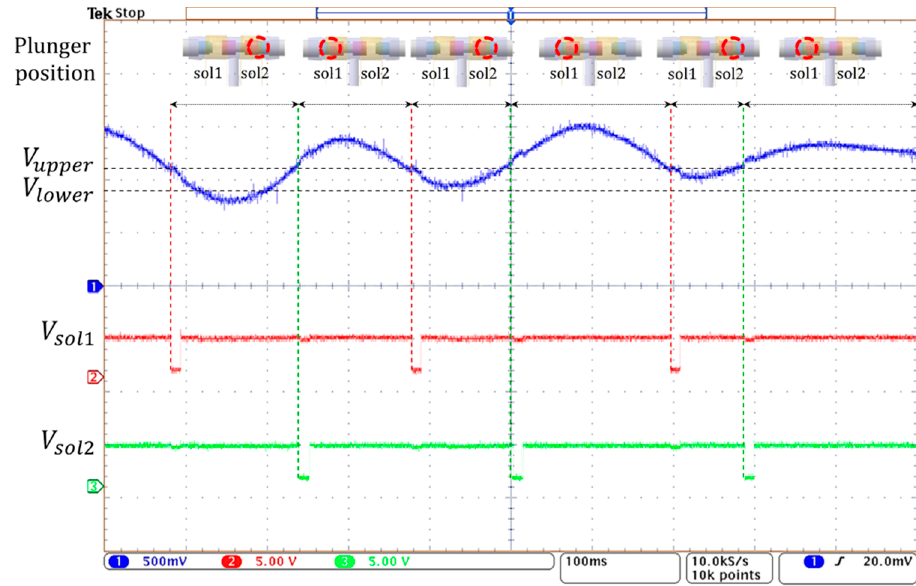
Figure 15. The operating waveform of 3-way pneumatic valve with hysteresis control.